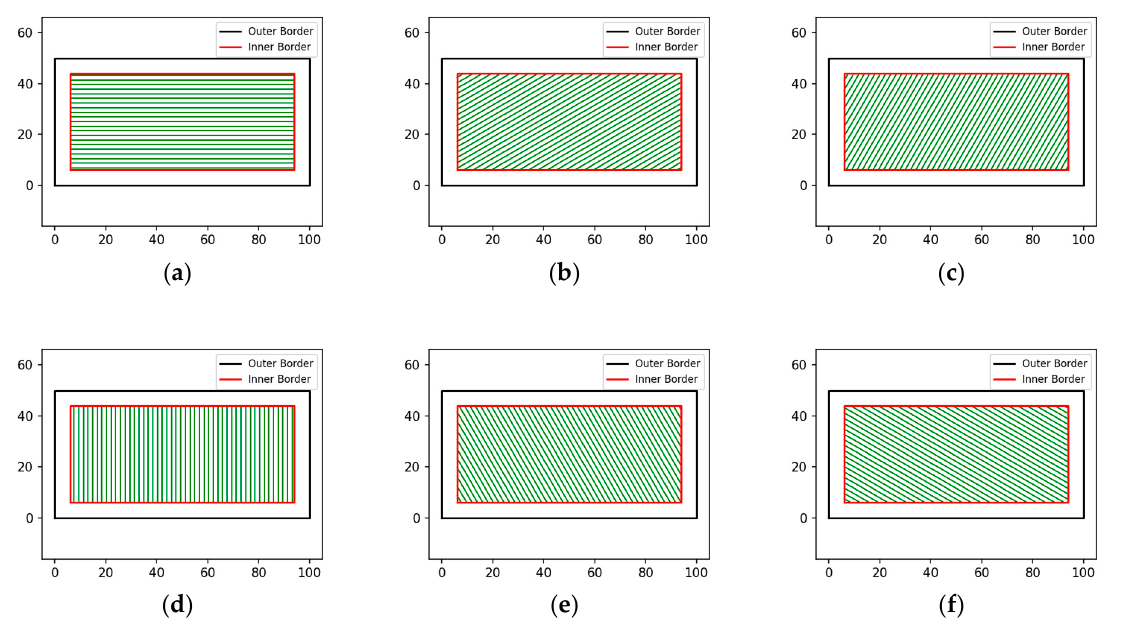
Figure 7. Six examples of infield tracks created by different travel directions: ( a ) Direction angle 0°; ( b ) Direction angle 30°; ( c ) Direction angle 60°; ( d ) Direction angle 90°; ( e ) Direction angle 120°; ( f ) Direction angle 150°.